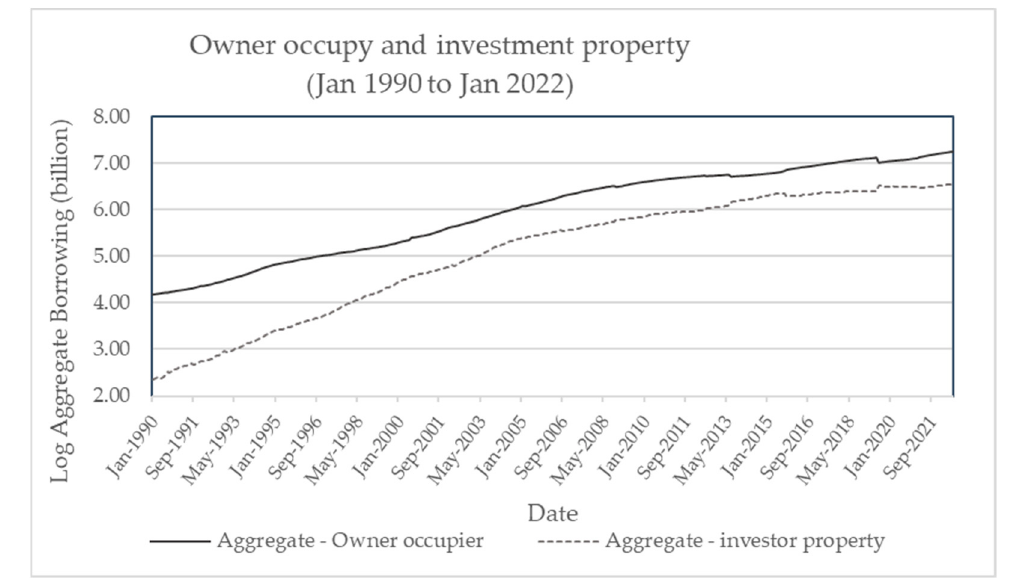
Figure 3. Aggregate borrowing (in log) (1990–2022).